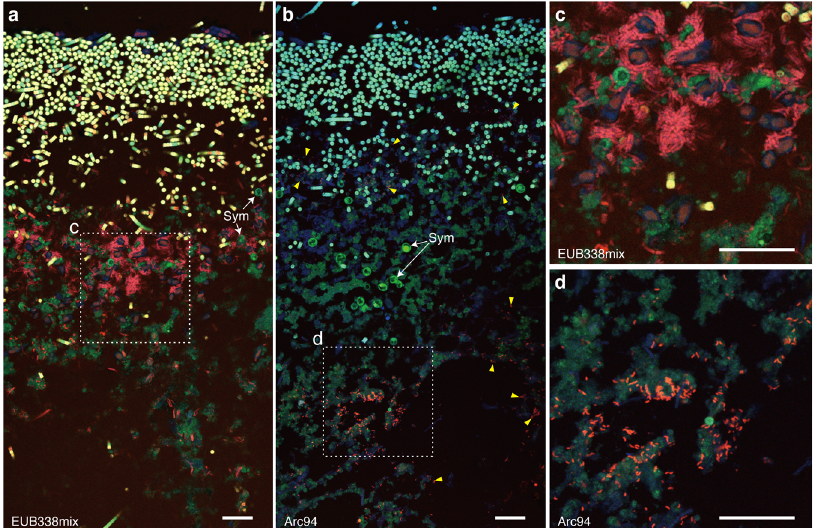
Fig. 5 Fluorescence in situ hybridization (FISH) using EUB338mix and Arc94 probes labeled with Cy3 showing respective bacterial localizations of all bacteria (a and c) and Arcobacteraceae (b and d) in serial cross sections of BBD specimens. Confocal merge micrographs of the microbial mat structure of BBD showing auto fl uorescence (blue indicates coral tissue and green indicate chlorophyll from symbiotic dino fl agellates [Sym] and cyanobacteria) and the hybridized bacteria with probe labeling Cy3 (red) ( a-d ). Cyanobacteria is shown in a yellow color that merged two channels from auto fl uorescence of chlorophyll and bacterial signals with Cy3 ( a and c ). Dotted lines in a and b delineate magni fi ed, close-up regions ( c and d ). Hybridized signals of Arcobacteraceae shows their assemblages and dispersed cells (dotted line and yellow arrowed heads in b ). Scale bars represent 30 µm.